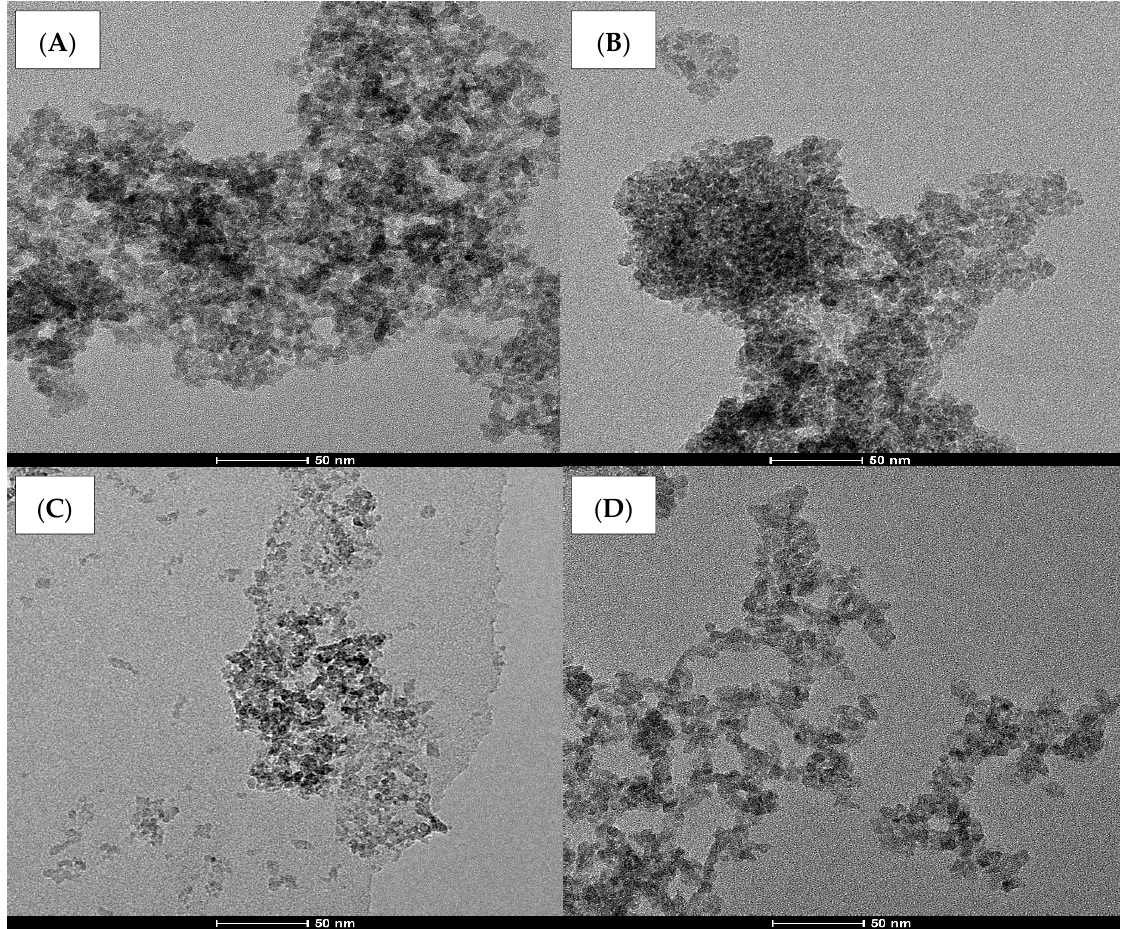
Figure 5. TEM micrographs of samples: ( A ) TiO 2 /N42, ( B ) TiO 2 /N42/Zr2.8, ( C ) TiO 2 /Zr2.8, and ( D ) TiO 2 /U4/Zr2.8.